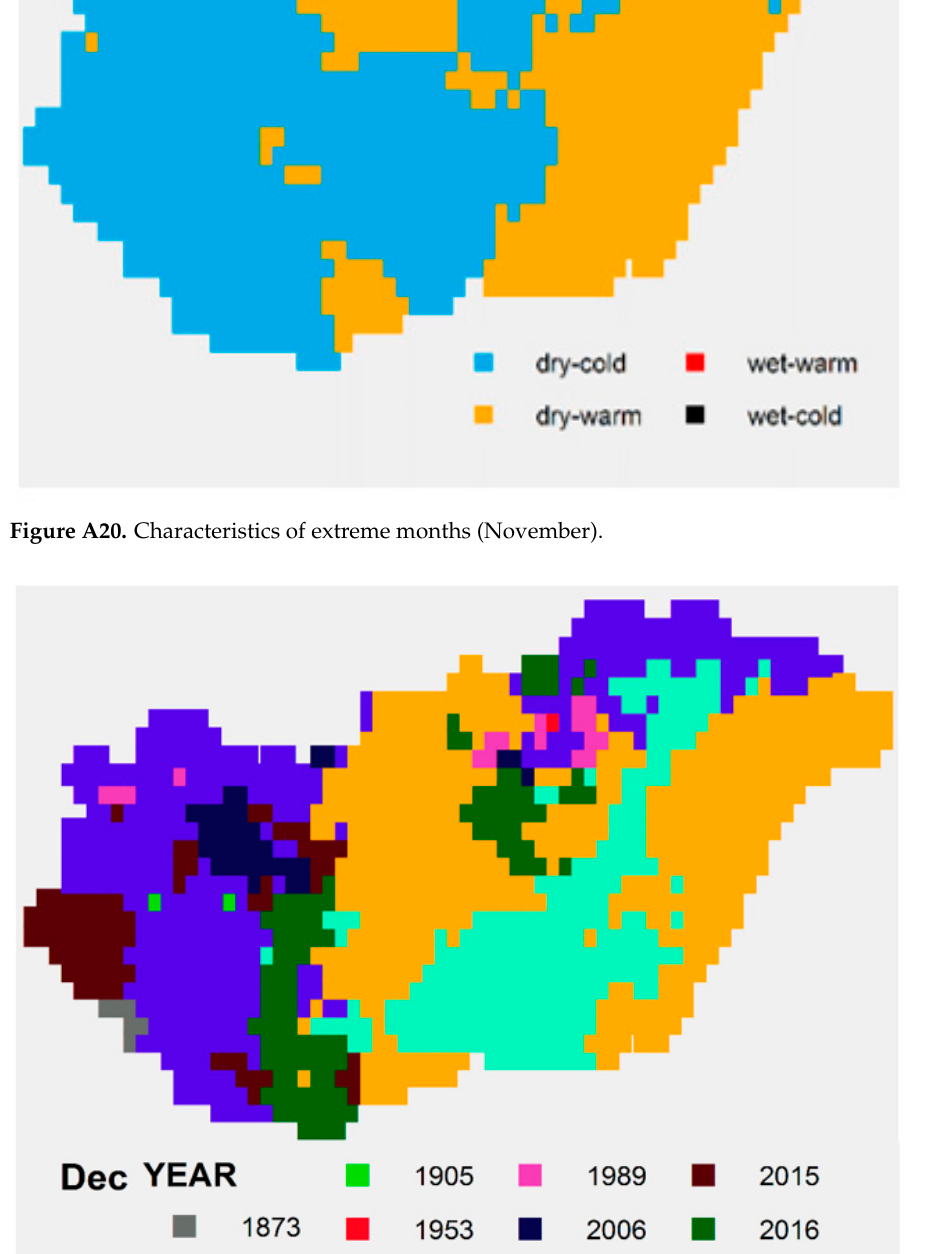
Figure A21. December: Year of maximum SPTI values, 1871–2020.